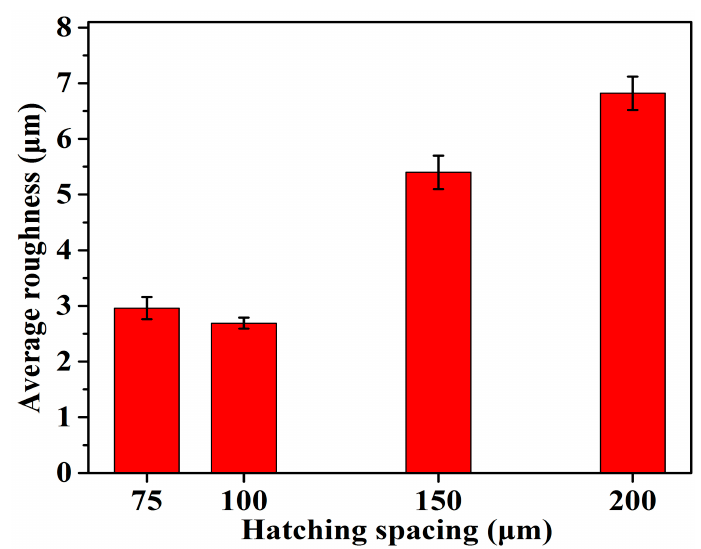
Figure 10. Average roughness of the top surface of the samples for different hatch spacings: ( a ) H = 75 μ m, ( b ) H = 100 μ m, ( c ) H = 150 μ m, and ( d ) H = 200 μ m.